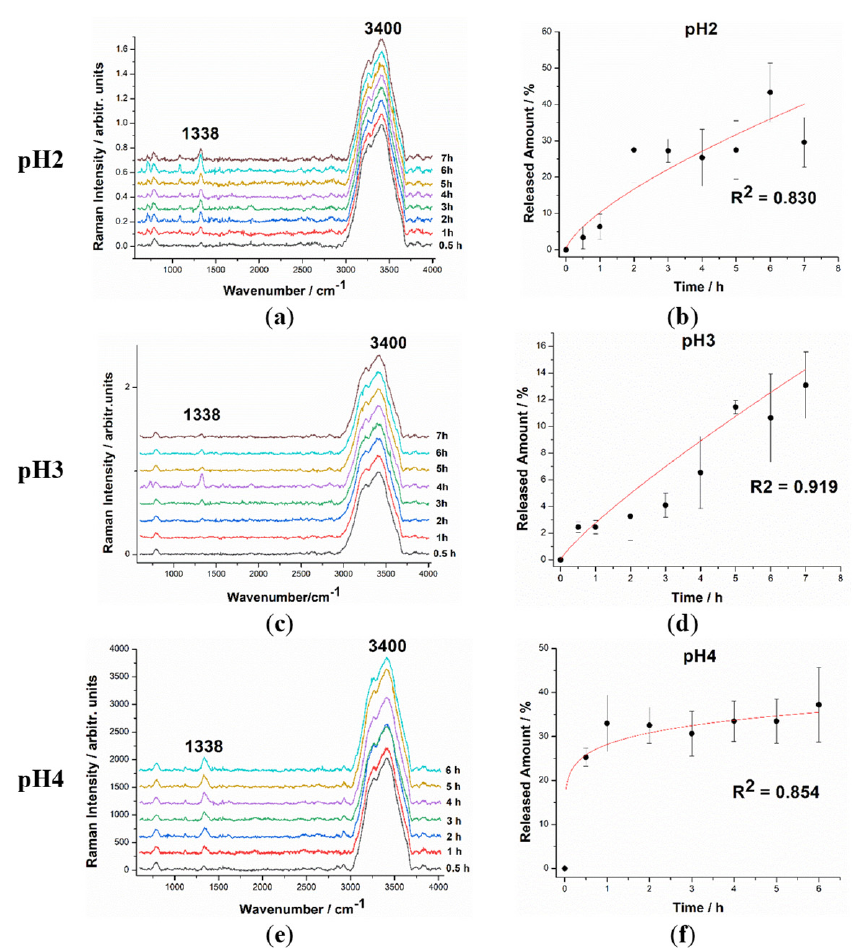
Figure 7. Averaged SERS spectra of the samples collected from the solutions containing the tablet over several hours of experiment for each pH value: pH 2 ( a ), pH3 ( c ), pH 4 ( e ). Released amount of FU from the tablet as a function of time for each pH value: pH 2 ( b ), pH3 ( d ), and pH 4 ( f ). The resulting graphs (Released Amount vs. Time) for each pH value can be seen in Figure 7b,d,f. The experiments were performed over a similar time span (6 and 7 h) as in our previous work, to be able to compare the release pattern in acidic solutions to the pattern in water. As previously stated, the releasing process began from the first hour of the tablet suspension and continued up to the 6th and 7th hours. From the tablets suspended in solutions of pH 2 and pH 4, the release seemed to slow down after the first 2 h of the experiment with ~30% of the total amount released after 2 h, but only 40% after 6 and 7 h, respectively. For the tablet suspended in pH 3 solution, the release pattern was slightly different, with the released amount having a more linear trend over the course of time. Although the data are plotted as means ( n = 3), the results are subject to significantly larger relative errors, which might be due to complex factors related to the calcium carbonate polymorphs (calcite and amorphous) behavior, the slow formation of MHC when the fraction of amorphous calcium carbonate coexisted in the presence of water, factors related to the AgNPs efficiency for SERS signal enhancement in complex solutions comprising multiple anions and cations, and related to the molecular behavior of 5-FU released in such complex aquatic media. Such influences include the dynamics of the CO 2 expected to occur in aqueous solution at acidic pH values, as a result of calcium carbonate reaction in acid conditions, the co-existence of Ca 2+ ions in solution and their slight influence on the AgNPs aggregation [40], subsequent 5-FU SERS intensity output, and the co-existence of CO 32 − /HCO 3 − in solution. The Fermi diads of solvated CO 2 in Raman spectra are